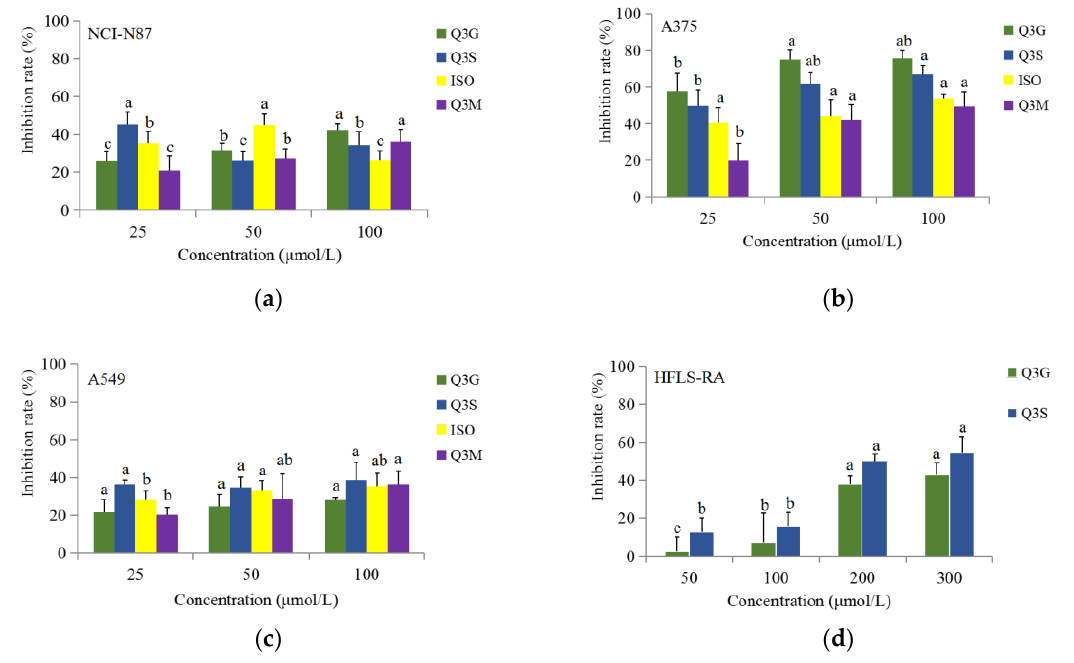
Figure 4. Anti-proliferative activity of flavonoids in NCI-N87 ( a ), A375 ( b ), A549 ( c ) and HFLS-RA cell line ( d ) by MTT assay (Q3G: quercetin-3-gentiobioside, Q3S: quercetin-3-sambubioside, ISO: isoquercetin, Q3M: quercetin-3-malonylglucoside; Different letters indicate significant difference between concentrations ( p < 0.05)).